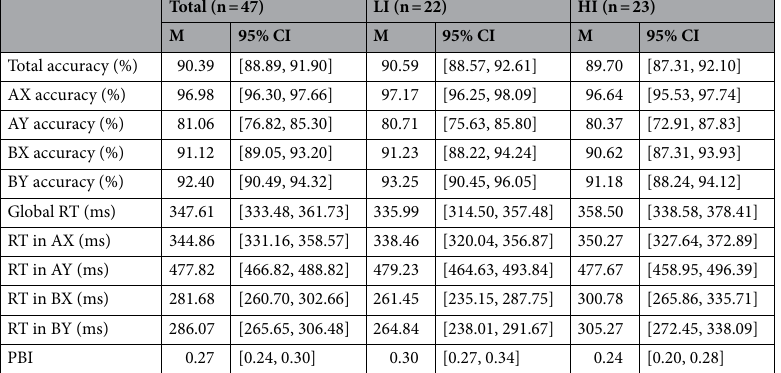
Table 1. Means and 95% Confidence Intervals in Global and By-Trials Accuracy (%) and Reaction Times in Correct Trials (RT, ms), and the Proactive Behavioral Index (PBI) in Low (LI) and High (HI) Impulsiveness Groups.